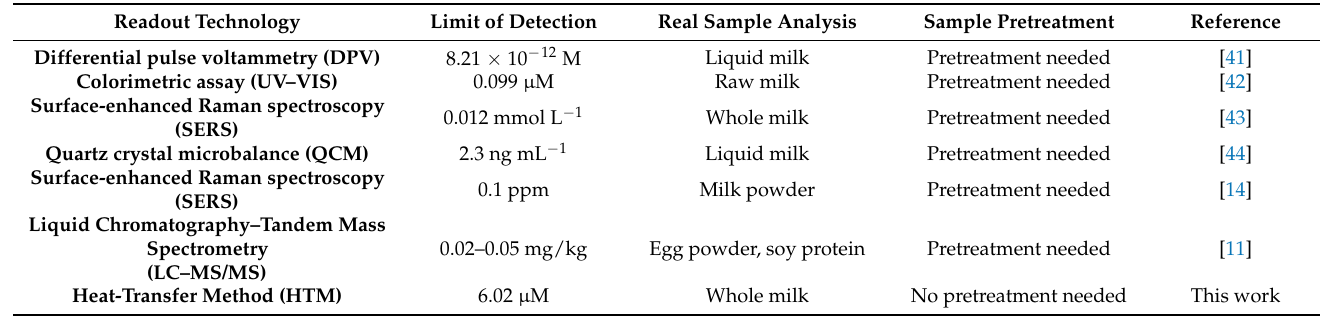
Figure 5. ( a ) Temperature profile and ( b ) dose–response curve obtained by an HTM analysis of the MIP/NIP-based receptor layer after infusions of different concentrations of melamine in spiked semi-skimmed milk samples. The black dashed line shows the LoD (3 σ method) at ± 6.02 μ M. The blue dashed line indicates the legal limit of melamine in milk set by EU/US regulators. Triplicate measurements were used to calculate the error bars and mean values. Table 3. Comparison of recently developed sensors for melamine detection in food